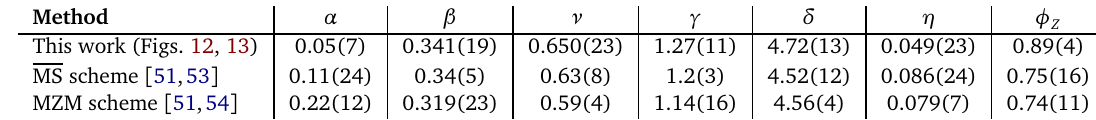
Table 4: O ( 2 ) × O ( 3 ) “antichiral / collinear” critical exponents.